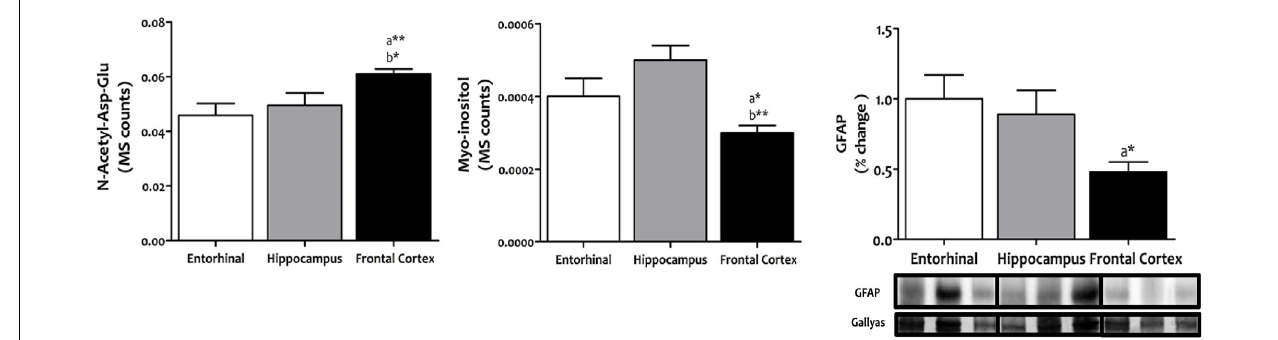
FIGURE 1 | Content of neurons and glial cells in different regions of the adult human cerebral cortex. N -acetyl-Asp-Glu was used as a marker for neuronal content, and myoinositol and GFAP as markers for glial cell content. N -acetyl-Asp-Glu and myoinositol were determined with TQMS, while GFAP was measured with